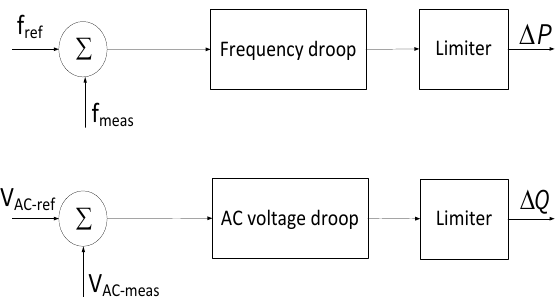
Figure 2. The block diagram of the droop control.